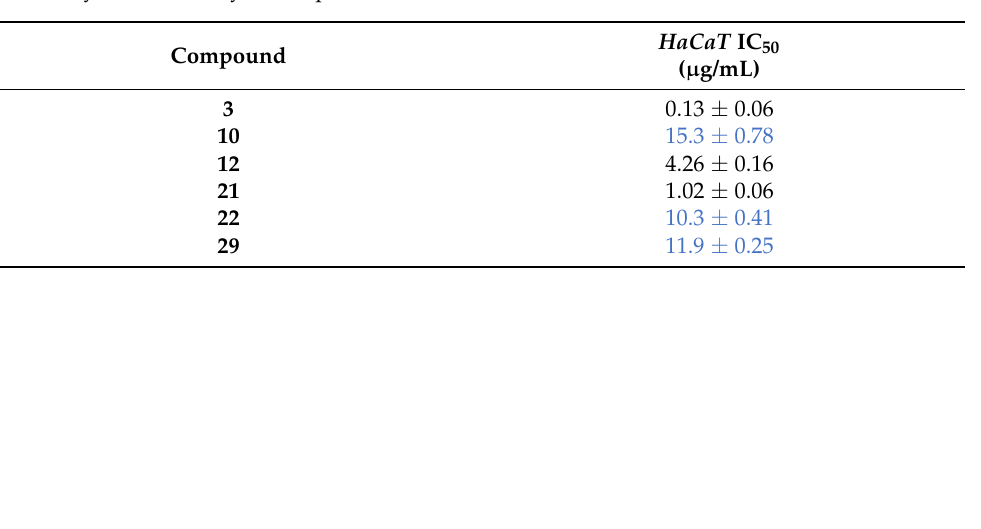
Figure 3. The effect of 3 , 10 , 12 , 21 , 22 and 29 on viability of HaCaT cell line. ( A ) Cytotoxic activity of compound 3 ; ( B ) Cytotoxic activity of compound 12 ; ( C ) Cytotoxic activity of compound 21 ; ( D ) Cytotoxic activity of compound 10 ; ( E ) Cytotoxic activity of compound 22 ; ( F ) Cytotoxic activity of compound 29 . Table 4. Cytotoxic activity of compounds 3 , 10 , 12 , 21 , 22 and 29 on HaCaT